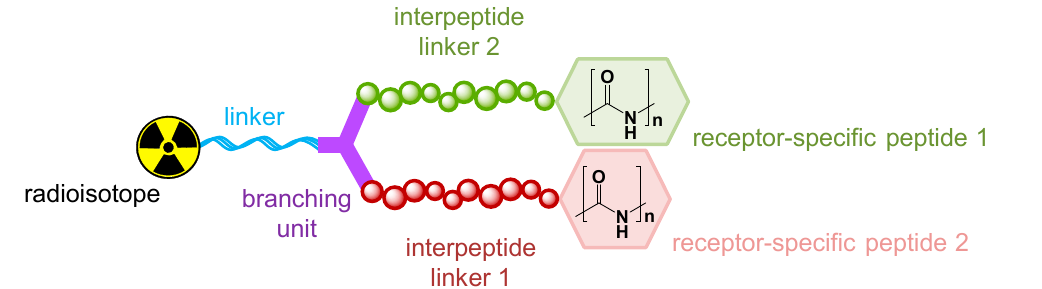
Figure 5. Schematic depiction of the molecular building blocks constituting the radiolabeled heterobivalent peptide.